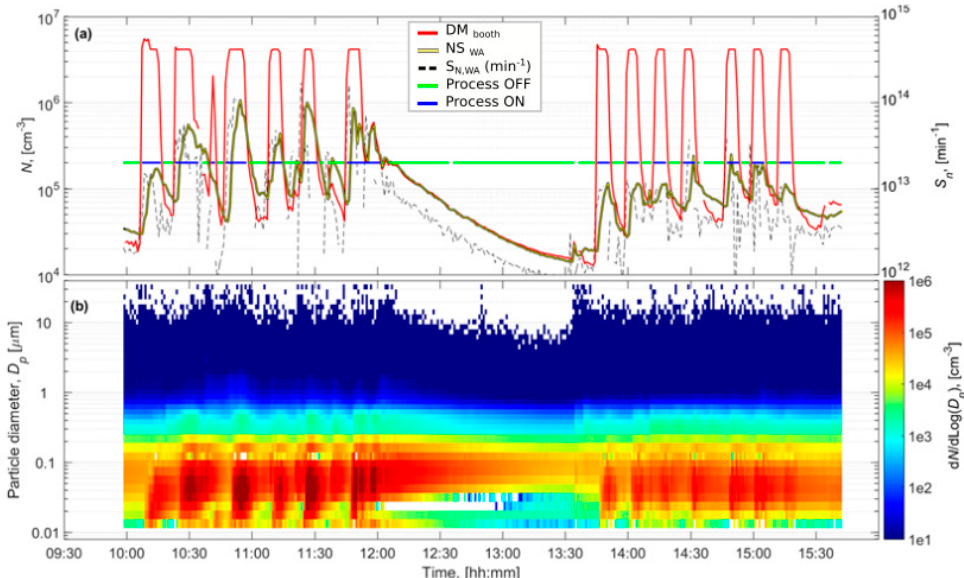
Figure 2. Booth #3, Day 3 (a) shows the particle number concentrations measured inside the booth by DiSCmini (DM), from worker area by NanoScan (WA) and particle emission rates solved by convolution from NanoScan WA concentrations. Blue line shows when the DM concentration was >10 5 cm –3 indicating that the plasma spray was ON and green line when the DM concentration was <10 5 cm –3 indicating that the plasma spray was OFF. Figure (b) shows the particle size distributions measured by the NanoScan in the WA.